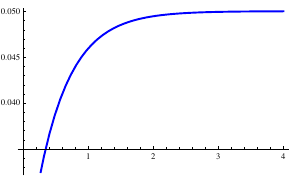
Figure 1. Synchronization loss in the case Figure 2. Synchronization loss in the case A = − 1 , 0 . 1 = ω 1 (cid:54) = ω 2 = 0 . Graphics of the A = − 1 , 0 . 1 = ω 1 (cid:54) = ω 2 = 0 . Graphics of the measure D ( t ) of the synchronization. Initial measure D ( t ) of the synchronization. Initial data θ (0) = 0 . 01 , φ (0) = 0 . 02. data θ (0) = 0 . 03 , φ (0) = 0 .